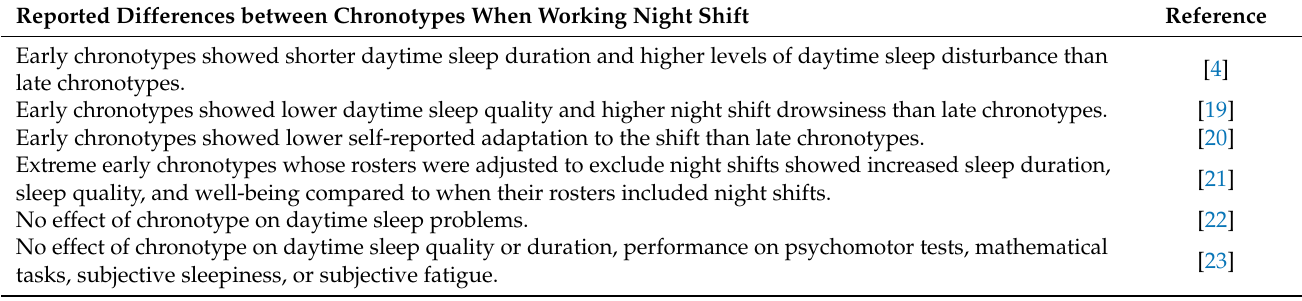
Table 1. Summary of the findings of studies that examined the effect of chronotype on daytime sleep and night shift performance. Reported Differences between Chronotypes When Working Night Shift Reference Early chronotypes showed shorter daytime sleep duration and higher levels of daytime sleep disturbance than late